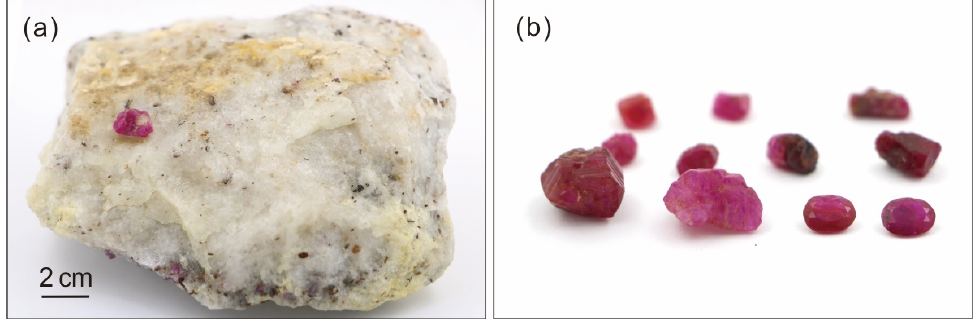
Figure 2. Structural map of Ailao Shan metamorphic range (modified after Leloup et al. [7]): MVF–mid-valley fault; RFF— range front fault. Figure 3. ( a ) Ruby-bearing marble and ( b ) secondary rubies (0.50–5 ct) from Yuanjiang,